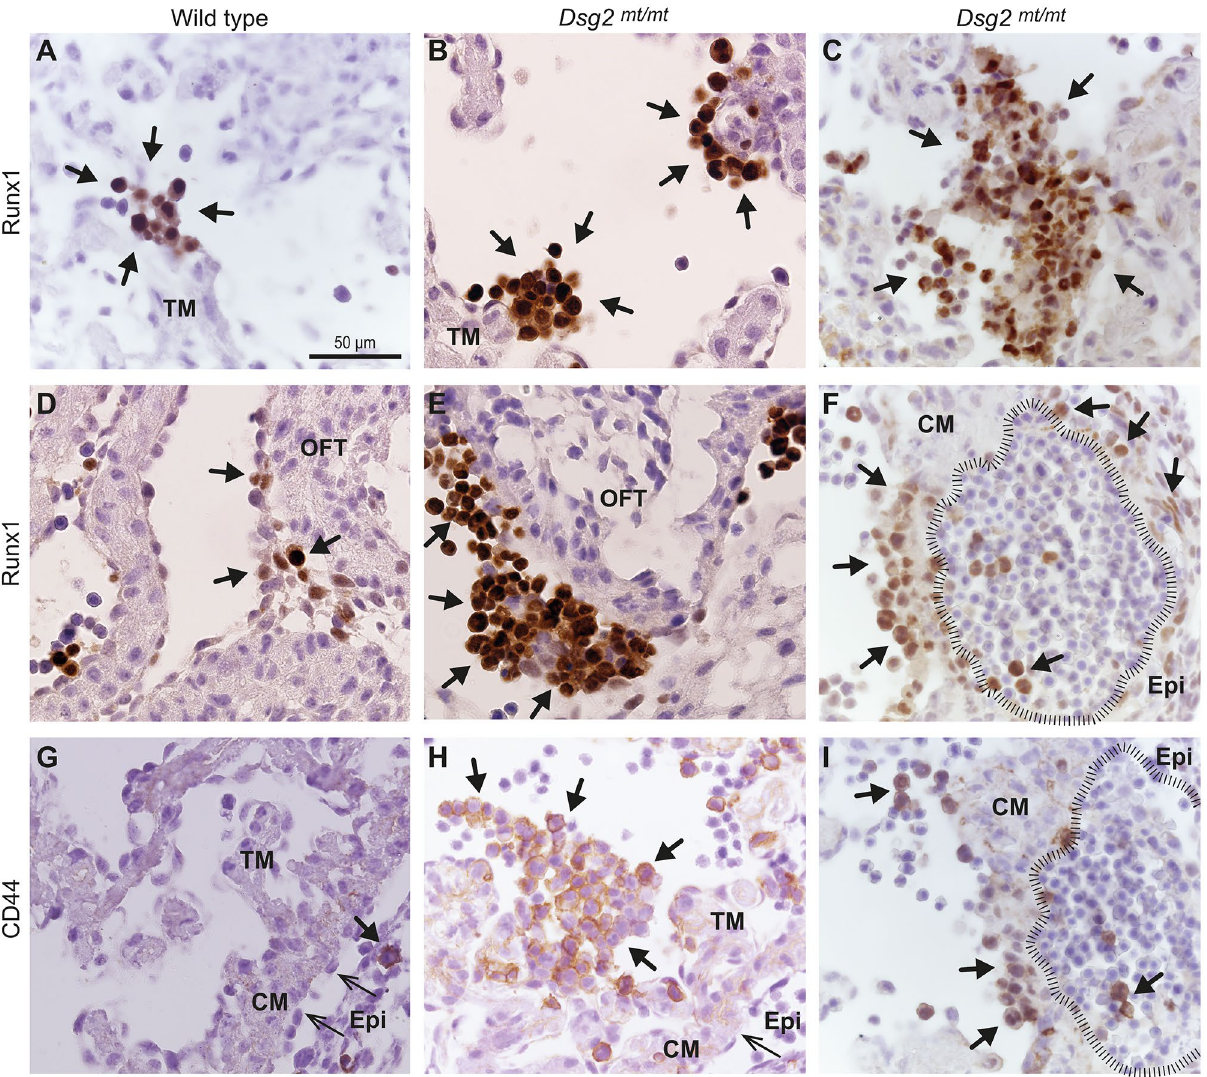
Figure 5. Hematopoietic stem and progenitor cells (HSPCs) expand in non-ruptured hearts of Dsg2 mt/mt embryos at E11.5. ( A ) Short arrows point to rarely detected nuclear Runx1 expression (brown) at the tip of trabecular myocardium (TM, arrows) in wild-type hearts. ( B – C ) Differently sized clusters of Runx1 + cells (short arrows) are depicted in the left ventricle protruding into the chamber lumen of Dsg2 mt/mt hearts. ( D , E ) Runx1 + cells (short arrows) are sparse in epi- and subepicardium of the outflow tract (OFT) in wild-type and abundant in the Dsg2 mt/mt heart. ( F ) depicts Runx1 staining in a type A cell cluster (short arrows on the left side of image) next to a type B cell cluster (striated line) and an abnormal epicardial bulge containing some Runx1 + cells. Note the presence of single Runx1 + cells within the differentiating and proliferating erythrocyte colonies. CM, compact myocardium. ( G ) shows a wild-type heart section immunostained for CD44. Arrow points to a single round-shaped cell in capillary (short arrow). Epi, epicardium (long arrows); CM, compact cardiomyocytes ( H ) CD44 + cells are detected in a type A cell cluster in the left ventricle of a Dsg2 mt/mt heart. ( I ) Single CD44 + cells are also detected next to type B cell cluster (striated line; serial section to F ). Data are representative images of n = 4–5 hearts per group and analysis. Size bar, 50 µm in ( A ) (same magnification in all other